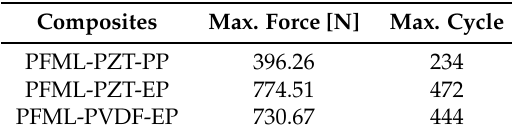
Table 4. Summary of the results from the dynamic three-point bending tests for the thermoplastic composites.